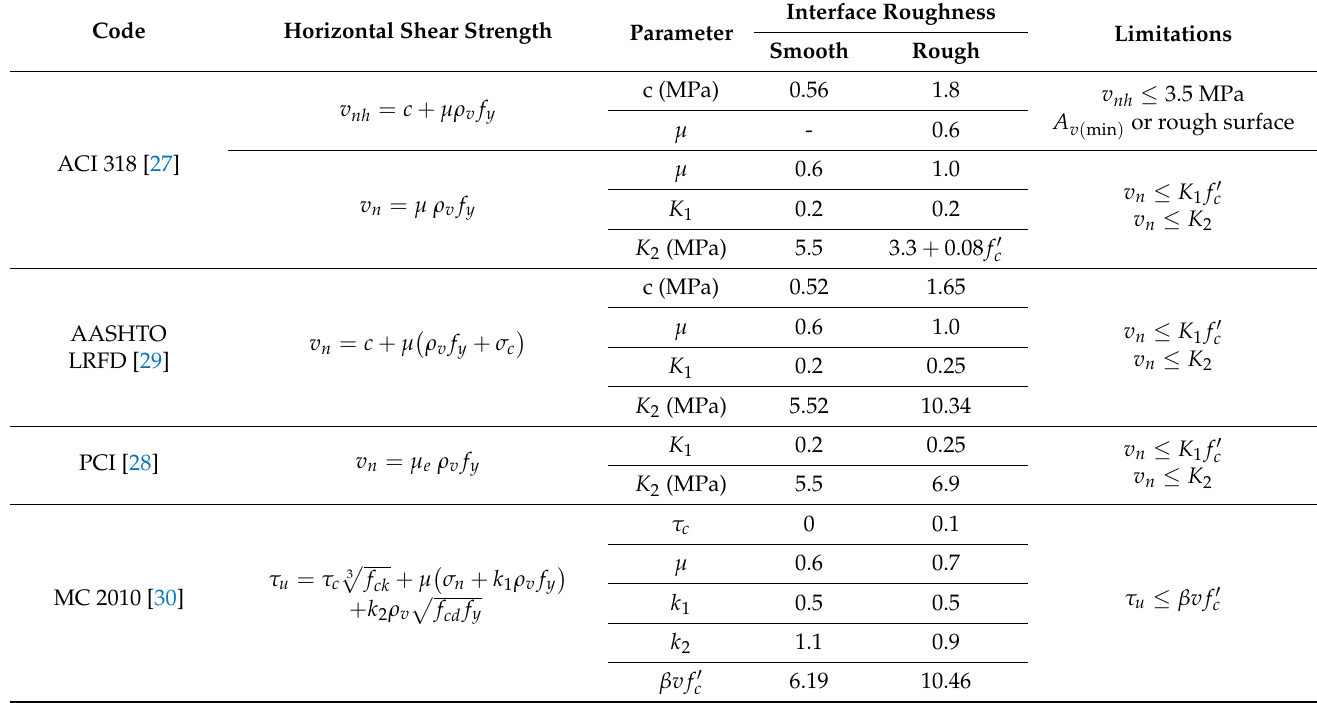
Table 2. Comparison of parameters and limitations in design codes.